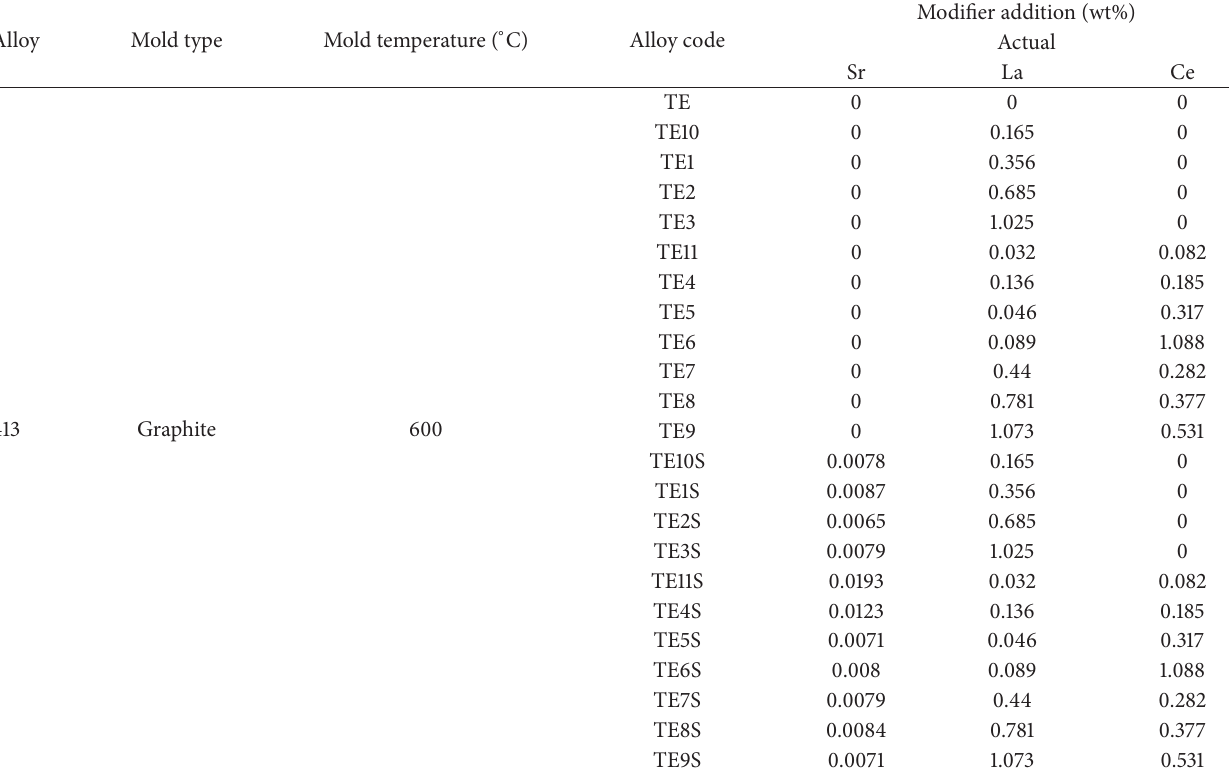
Table 3: Modifier additions and corresponding alloy codes for 413